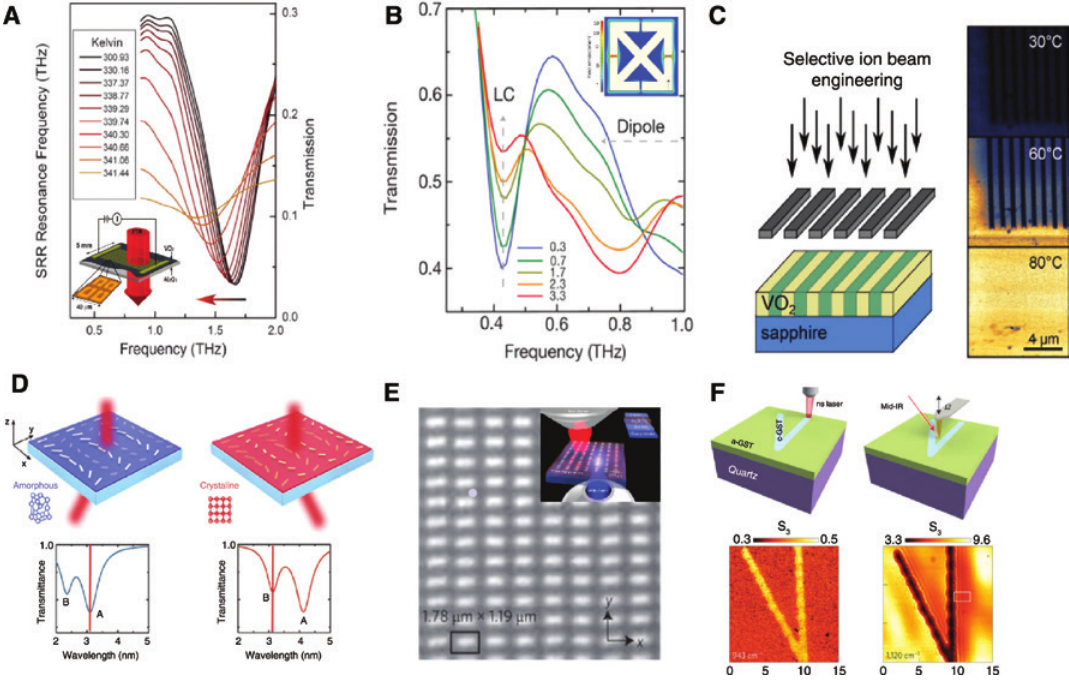
Figure 8: Phase-transition materials for metasurface